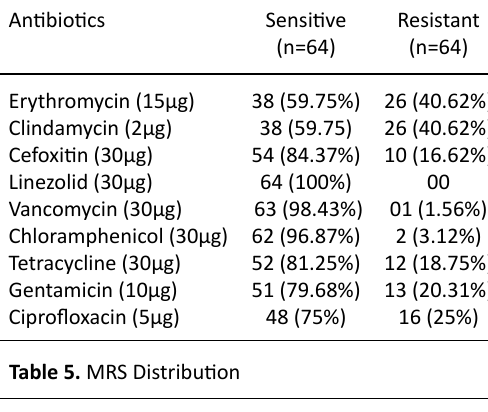
Table 4. Antibiotic Susceptibility profile for Gram Positive Bacteria